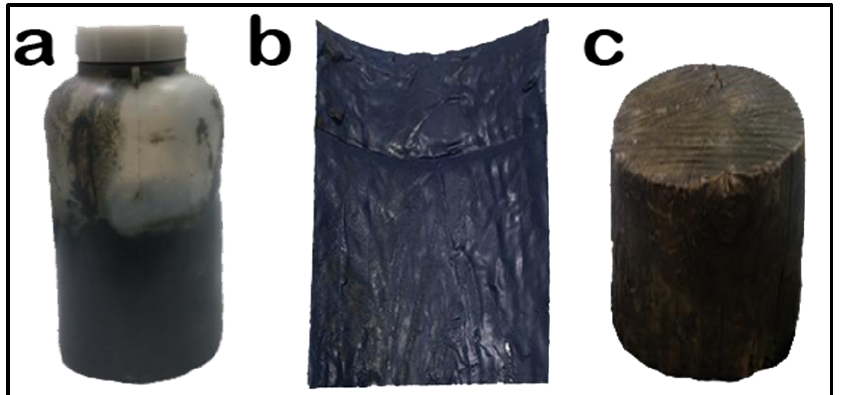
Figure 1. Waste materials, ( a ): Petroleum containing sludge (NAS-1), ( b ): Scrap metal paint residue (NAS-2), and ( c ): Creosote-treated wood